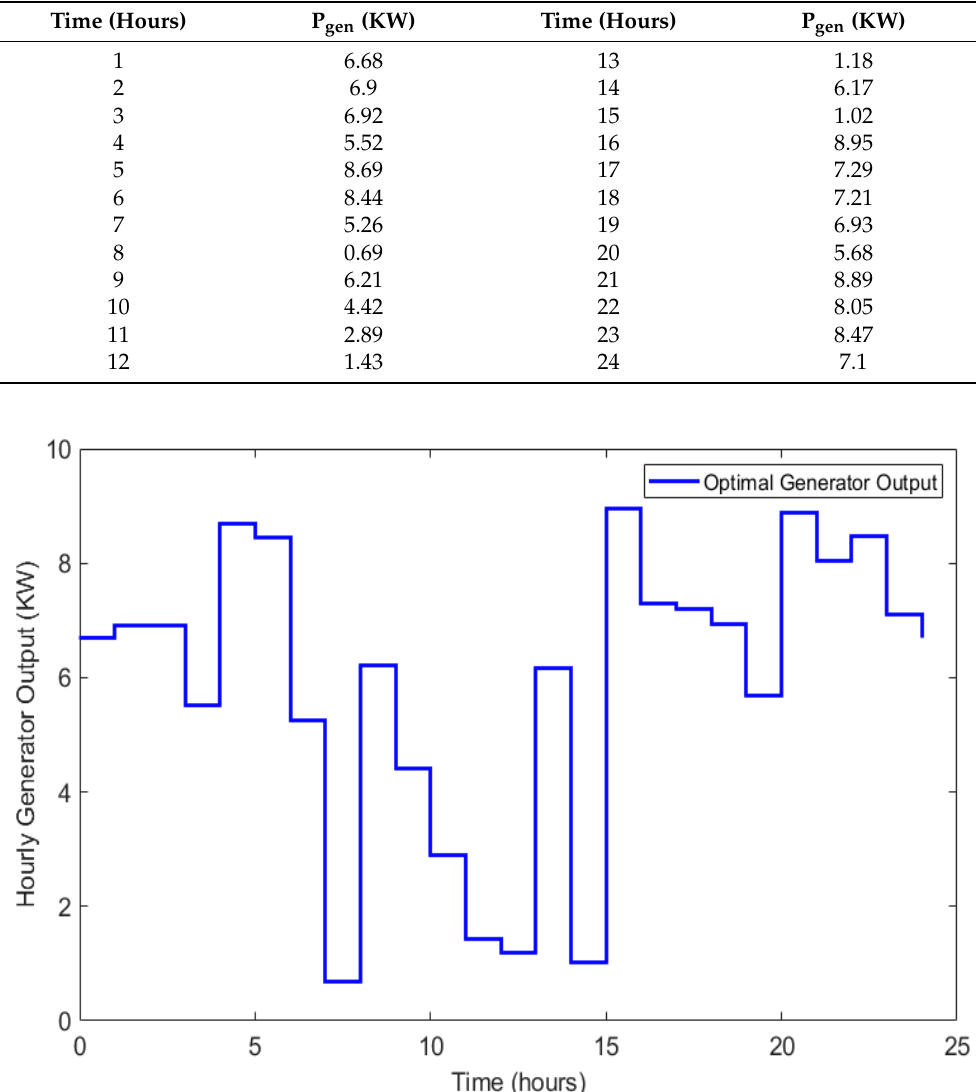
Figure 8. Optimal hourly output power of the conventional generator.